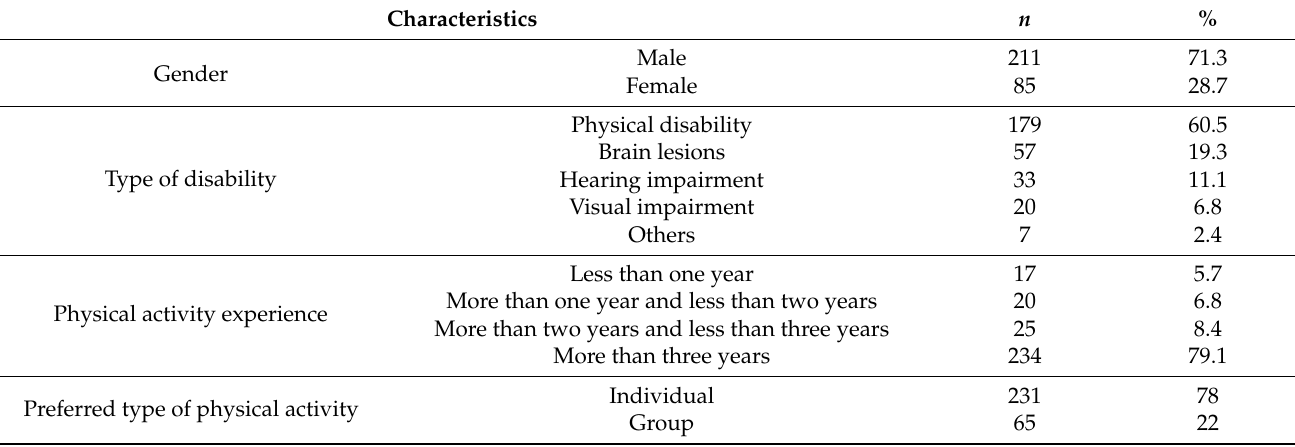
Table 1. Socio-demographic characteristics of the participants ( n =